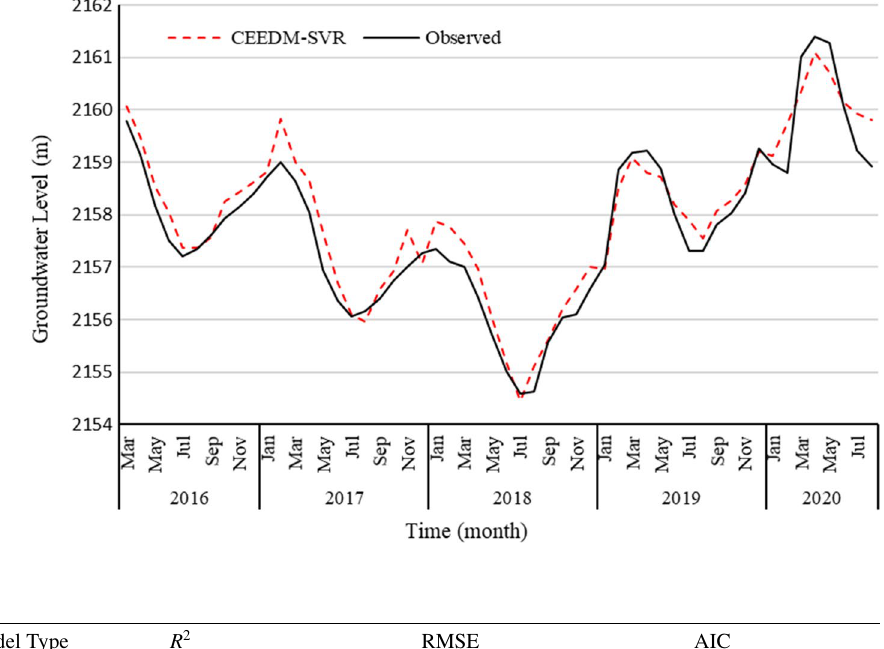
Table 10 Comparison of the models used in this study